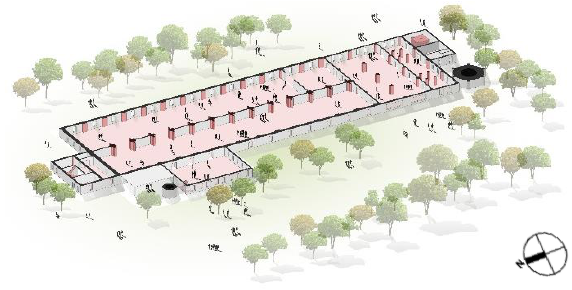
Figure 5 . Design hypothesis ground floor – Ex Cartiera